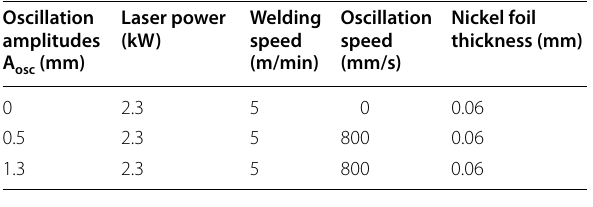
Table 2 The parameters of laser oscillating welding Oscillation amplitudes